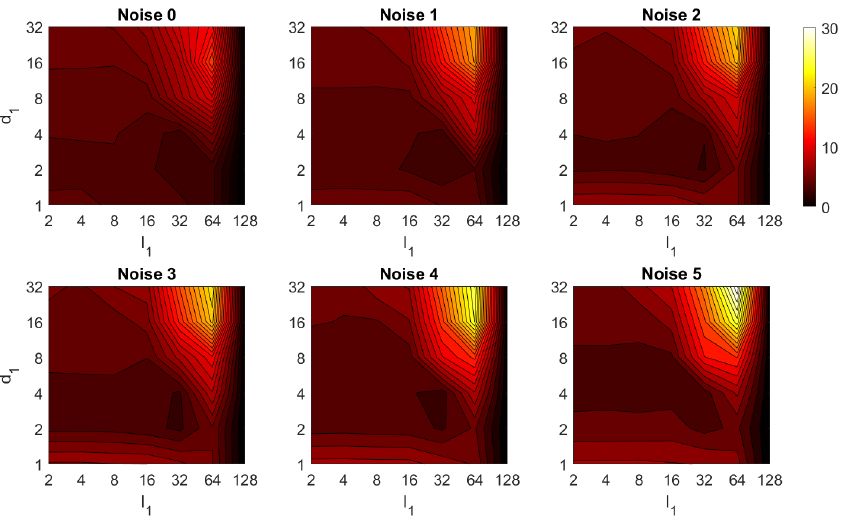
Figure 33. HOG orientation estimation in the presence of noise. Average orientation error (deg).